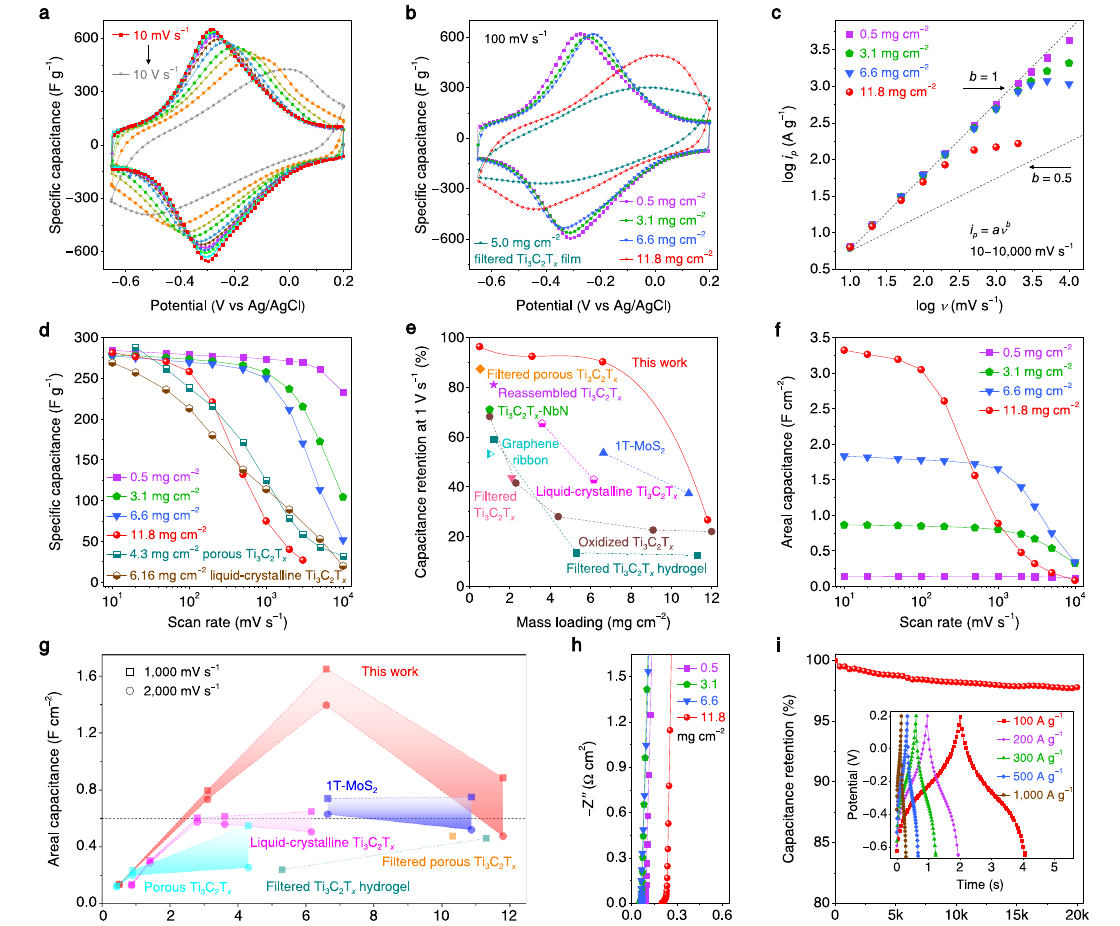
Fig. 3 | Electrochemical performance of 4D-printed Ti 3 C 2 T x hydrogel electro- des. a CV curvesofTi 3 C 2 T x hydrogel(0.5mgcm − 2 ) atscanrates of 10,20, 50, 100, 200, 500, 1000, 2000, 3000, 5000, and 10,000mV s − 1 . b CV curves of Ti 3 C 2 T x hydrogelswithdifferentmassloadingsatascanrateof100mVs − 1 . c Determination of the slope, b -value, for Ti 3 C 2 T x hydrogels with different mass loadings. d Rate performance of Ti 3 C 2 T x hydrogels at scan rates from 10 to 10,000mVs − 1 . The porous Ti 3 C 2 T x (4.3mgcm − 2 ) 12 and liquid-crystalline Ti 3 C 2 T x (6.16mgcm − 2 ) 41 are plotted for comparison. e Capacitance retentions of Ti 3 C 2 T x hydrogels with dif- ferent mass loadings at 1Vs − 1 . Lots of high-rate electrodes are listed for compar- ison, including fi ltered porous Ti 3 C 2 T x 43 , reassembled Ti 3 C 2 T x 50 , Ti 3 C 2 T x -NbN 51 , graphene ribbon 52 , fi ltered Ti 3 C 2 T x 53 , liquid-crystalline Ti 3 C 2 T x 41 , 1T-MoS 2 42 ,